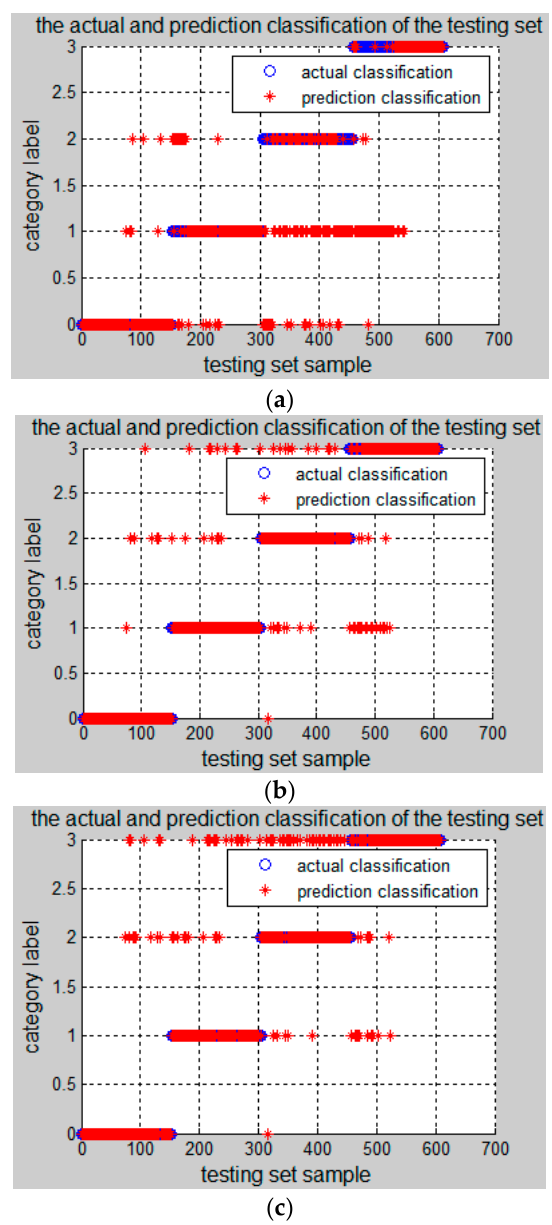
Figure 5. Fault isolation results of other algorithms. ( a ) SVM testing results; ( b ) GridSearch-SVM testing results; ( c ) GA-SVM testing results. Table 5. Comparison of PSO-SVM with other commonly used classifiers.